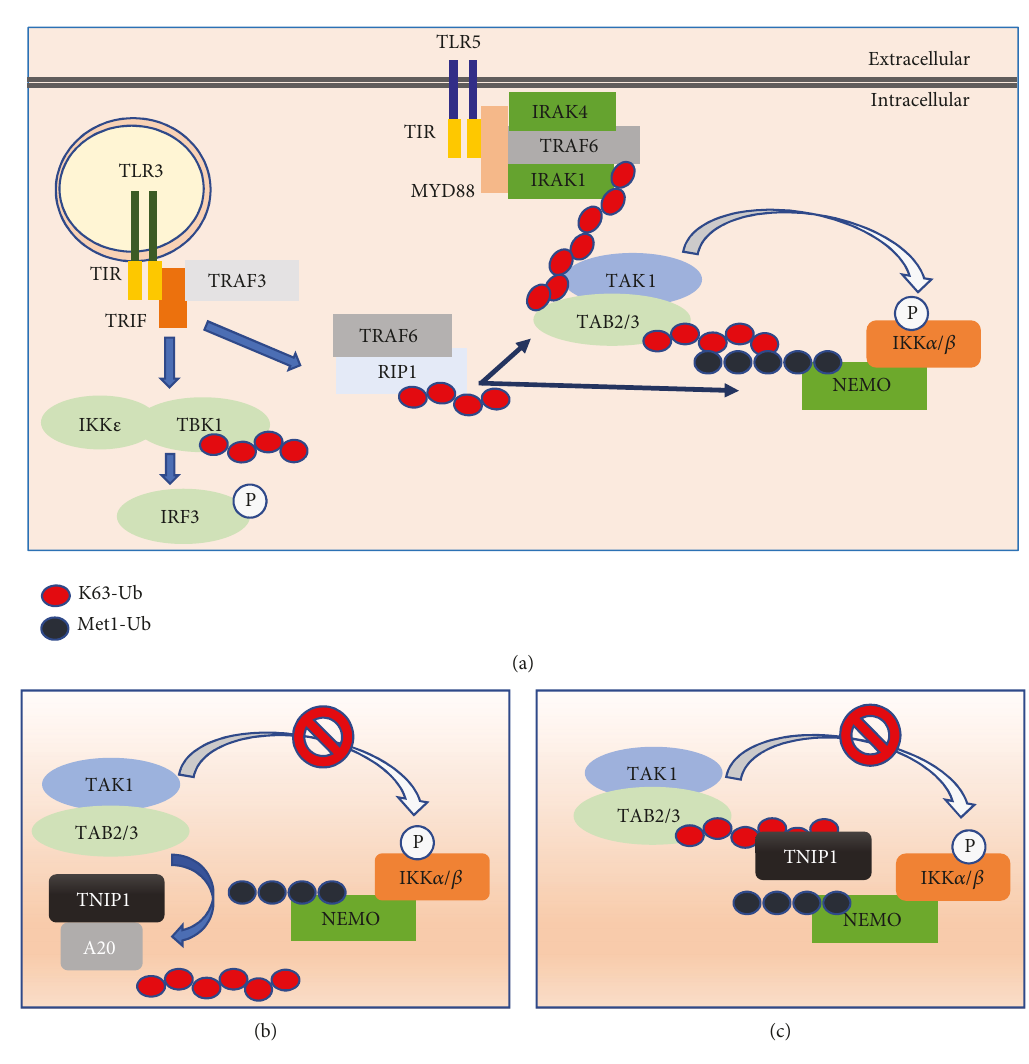
Figure 1: Toll-like receptor signaling — regulation by TNIP1. (a) With TLR dimerization and recruitment of adaptor proteins at the membrane level, ubiquitination of target proteins promotes activation of kinase activity and complex formation. Diverse consequences occur depending on the TLR activated. In the case of TLR3-TRAF3-TRIF, TBK1 becomes ubiquitinated and, in combination with IKK ε , promotes phosphorylation of transcription factors (IRF3) upstream of interferon secretion. TLR3 activation may also promote RIP1 ubiquitination, which allows for RIP1 to interact with TAK1/TAB2/3 or NEMO, resulting in gene transcription events regulating in fl ammation and apoptosis. IRAK1 becomes ubiquitinated followed by TAK1 activation with TAB2/3 binding K-63 linked ubiquitin which forms a hybrid complex with linear (Met1-linked) ubiquitin on NEMO allowing for TAK1 to phosphorylate IKK β . This eventually results in the release of NF- κ B subunits from I κ B α . TNIP1 regulation of these events is believed to occur by (b) removal of K63-linked ubiquitin chains via TNIP1/A20 binding and A20 de-ubiquitinase activity and/or (c) inhibition of complex formation by competition for polyubiquitin